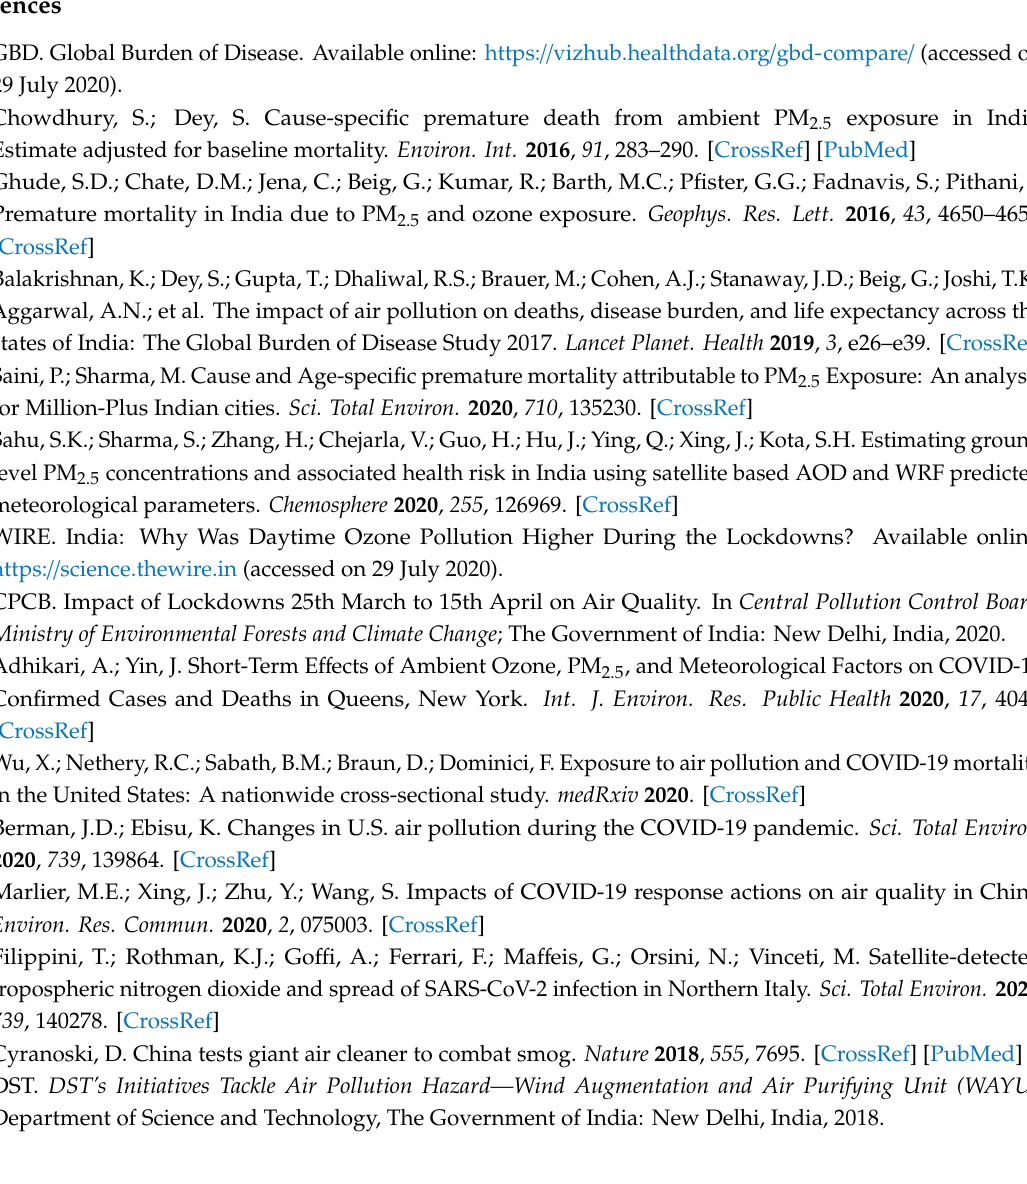
Table S1: Summary of air quality in 124 cities in India for the periods before and during the 4 COVID-19